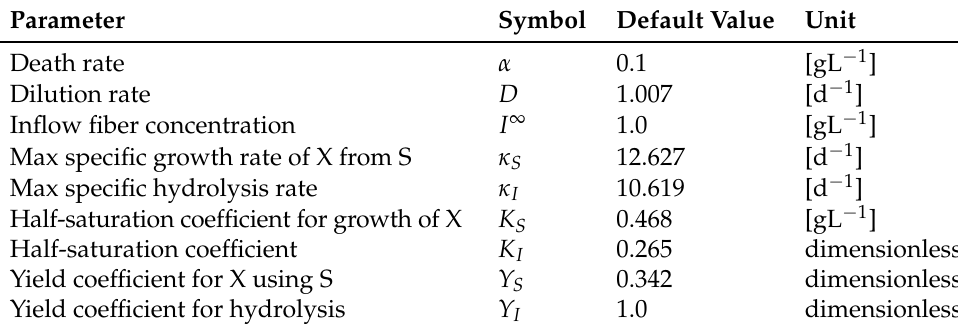
Table 1. Mean values of parameters used in numerical simulations of single compartment model, adapted from [17].